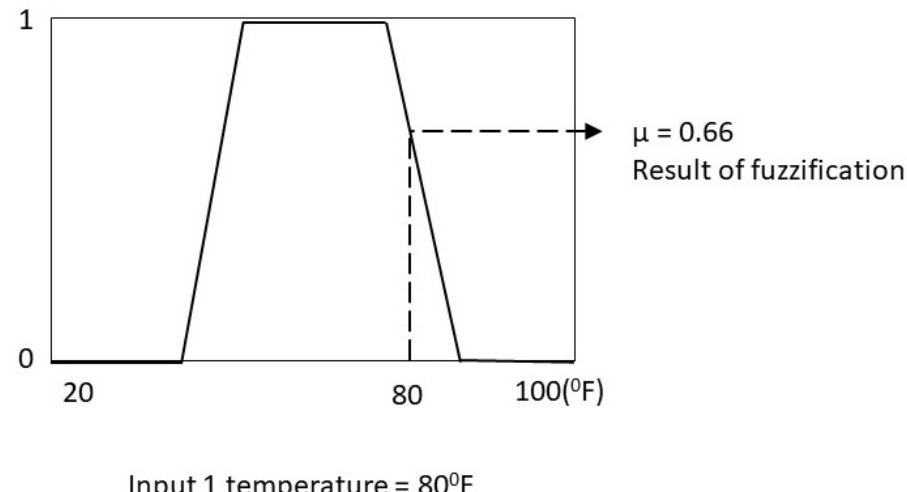
Figure 3. Fuzzification of Input variable